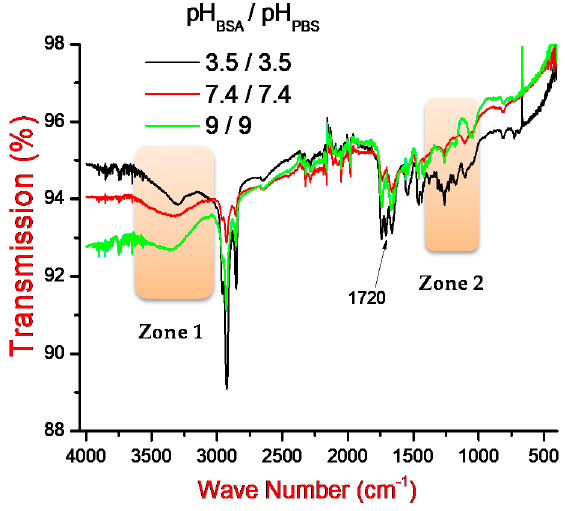
Figure 8. FTIR spectra of MIP response at pH BSA /pH PBS adjusted to (3.5/3.5), (7.4/7.4) and (9/9). Results show a variation in the band intensities at pH 3.5 in the zone 1, ranging from 3500 to 3300 cm − 1 . This can be attributed to the asymmetric valence vibrations of the am ‐ monium ion ( NH (cid:2871)(cid:2878) ) formed during the (R ‐ NH (cid:2870) (cid:4667) protonation by the influence of the hydro ‐ nium cation (cid:4666)H (cid:2871) O (cid:2878) (cid:4667) . At pH 7.4 and 9, these bonds are large and present a higher absorp ‐ tion intensity, which is probably due to different intermolecular hydrogen bonds. The peaks recorded in the zone 2 (1300–1200 cm − 1 ) and around 1720 cm − 1 , for the MIP designed to the appearance of the β‐ sheet conformation [45].